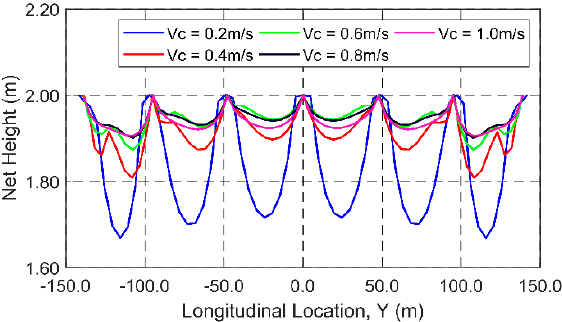
Figure 7. Envelopes of the vertical responses (net-top motion minus net-bottom motion) of the net assembly at different current velocities.